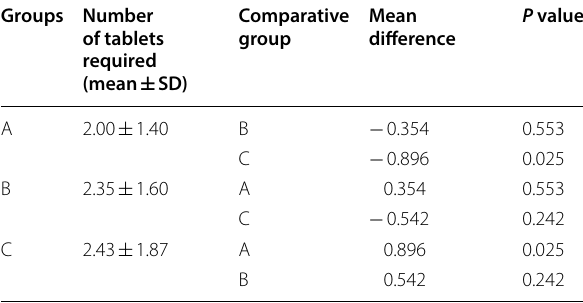
Table 9 Comparison of requirement of analgesic tablets Groups Number of